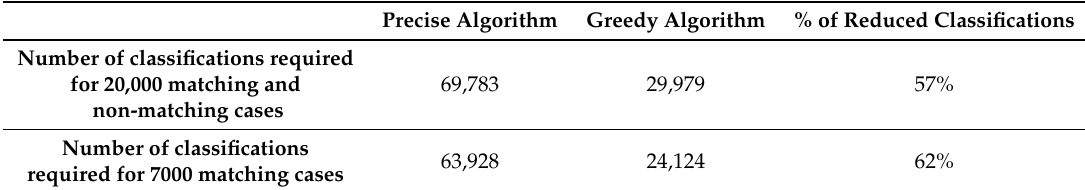
Table 5. The number of operations performed by the precise and greedy versions of the automatic POIs matching